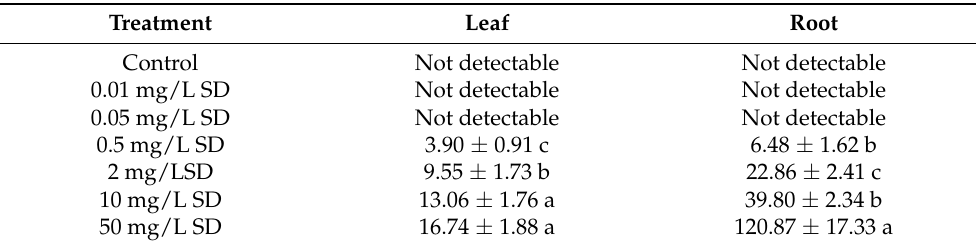
Table 2. Concentrations ( μ g/kg in dry mass) of SD (±standard deviation) in the roots and leaves in different treatments.